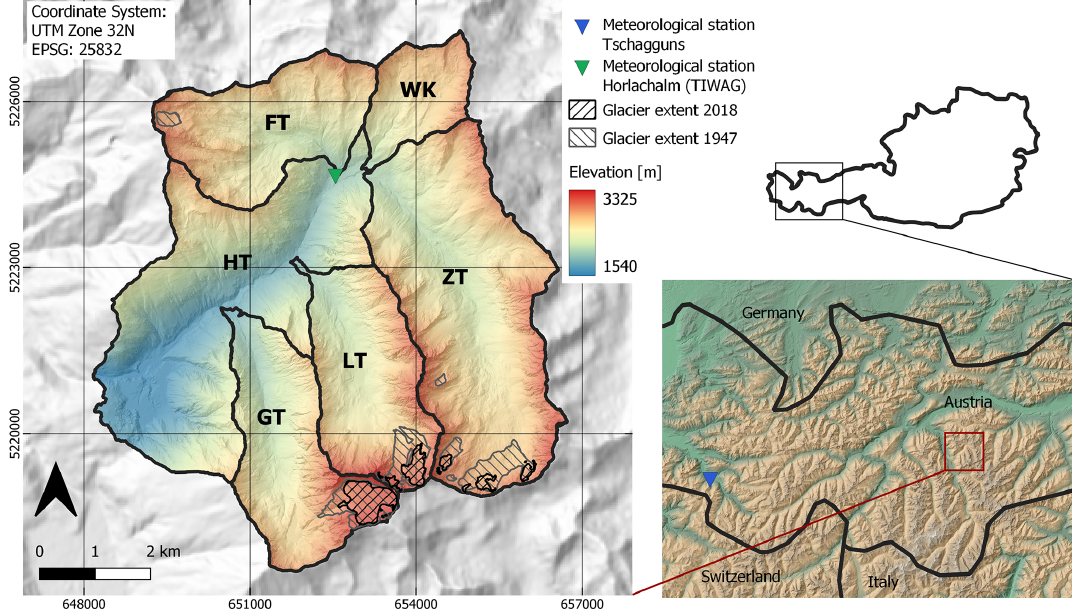
Figure 1. Location of Horlachtal in the Stubai Alps. The study area is divided into the sub-catchments main valley (HT), Grastal (GT), Larstigtal (LT), Zwieselbachtal (ZT), Weites Kar (WK) and Finstertal (FT). Shown glacier extents were mapped based on orthophotos of the corresponding years. Elevation data of the study area are based on airborne lidar data from 2019. Large-scale elevation data in the background are based on the ALOS global digital surface model © JAXA. Table 1. Attributes of the different sub-catchments in the study area based on airborne lidar data of 2017 (Province of Tyrol). Sub-catchment Area Glaciated Glaciated Elevation Elevation Elevation Elevation